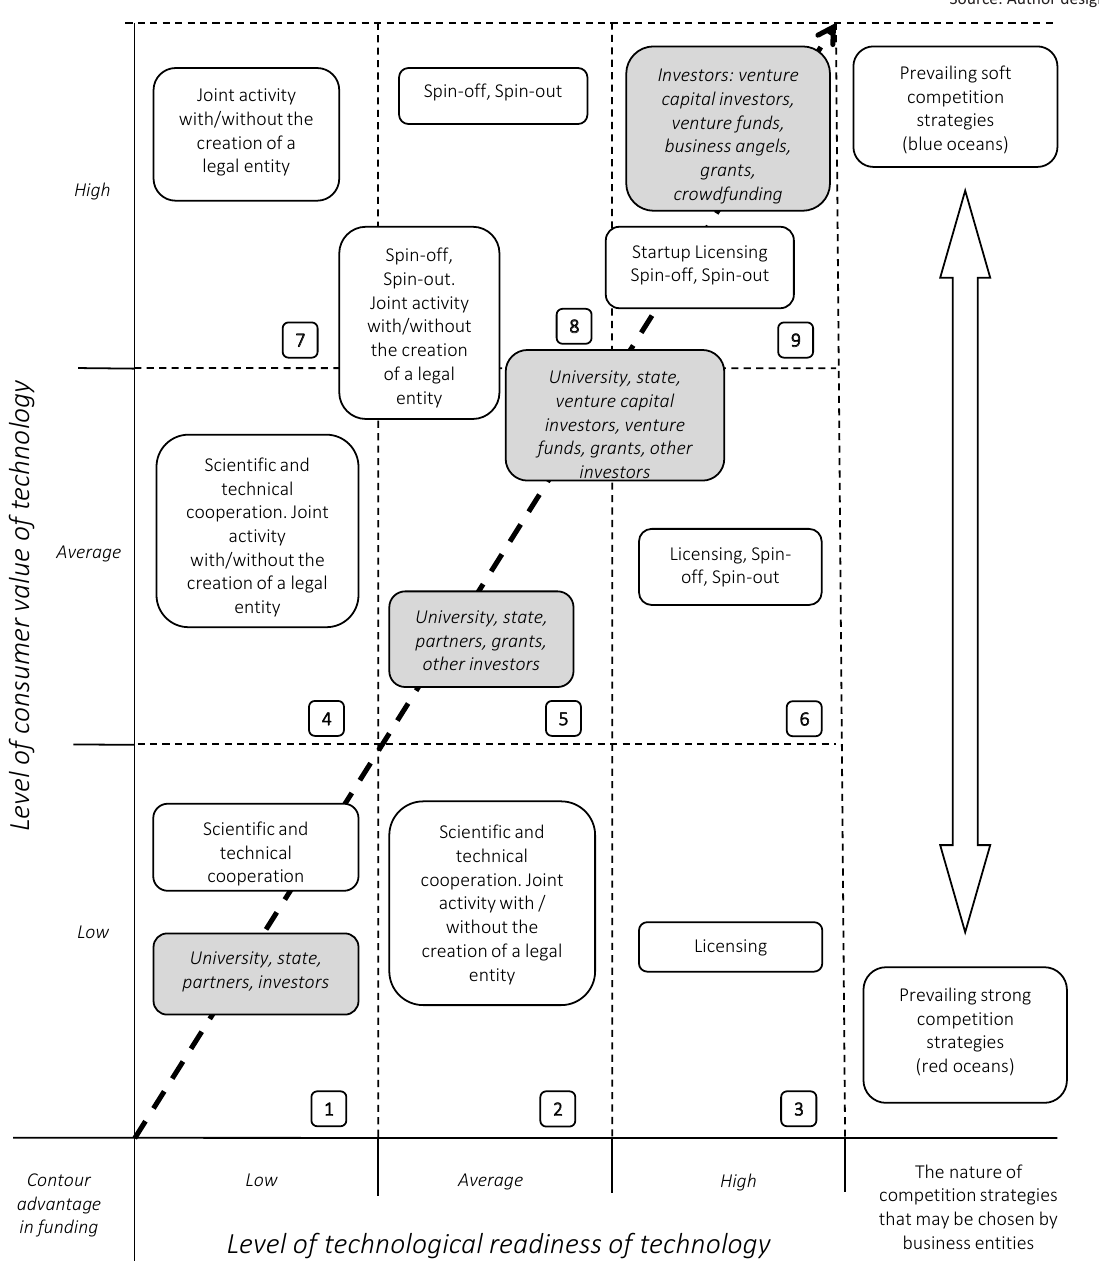
Figure 3. Selection matrix of technology transfer models on the correlation of the technology consumer value and its technological